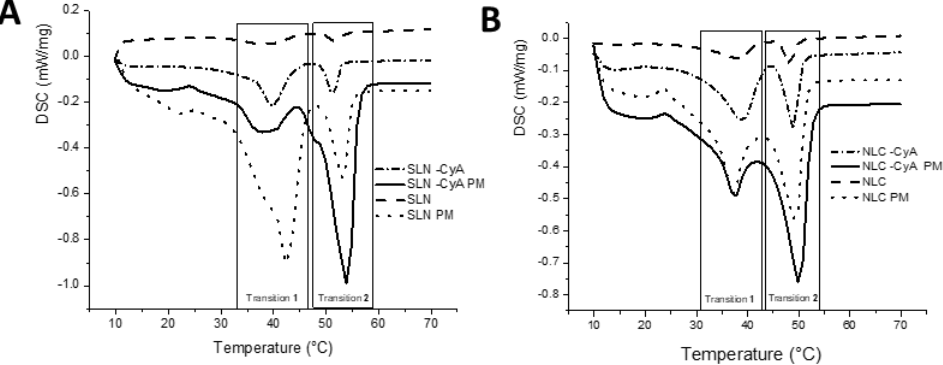
Figure 2. Interactions of Lipocire DM-based lipid nanoparticles and CsA. Differential scanning calorimetry (DSC) thermograms of ( A ) SLNs, SLNs physical mixture (SLNs-PM), SLNs-CsA, and SLNs-CsA PM; and ( B ) NLCs, NLCs physical mixture (NLCs-PM), NLCs-CsA, and NLCs-CsA PM. Table 2. DSC parameters of SLNs, SLNs-CsA, NLCs, and NLCs-CsA.